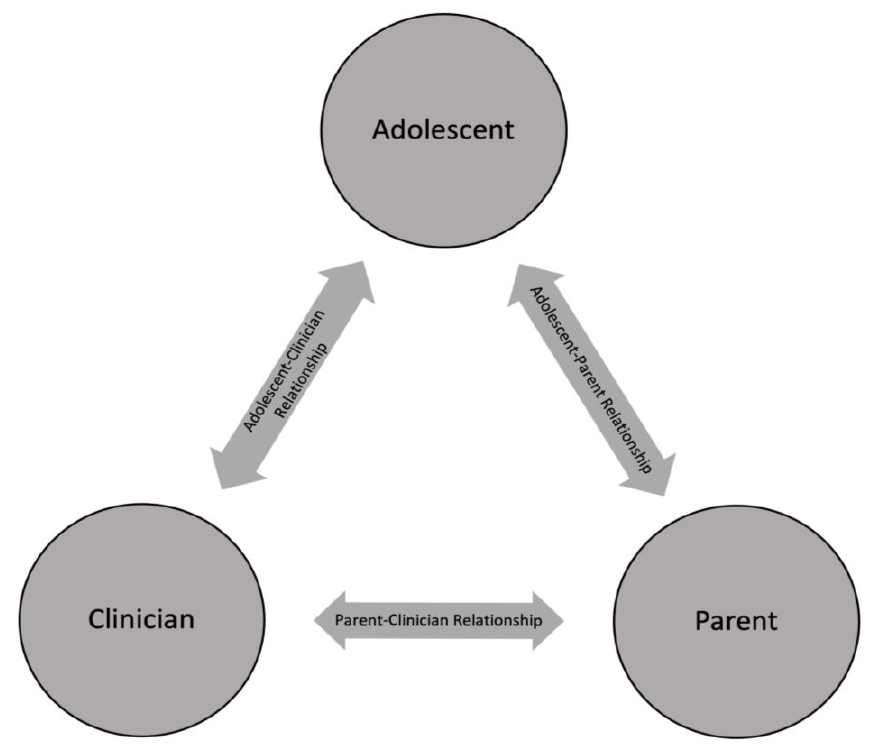
Figure 1. Triad of stakeholders in adolescent healthcare.